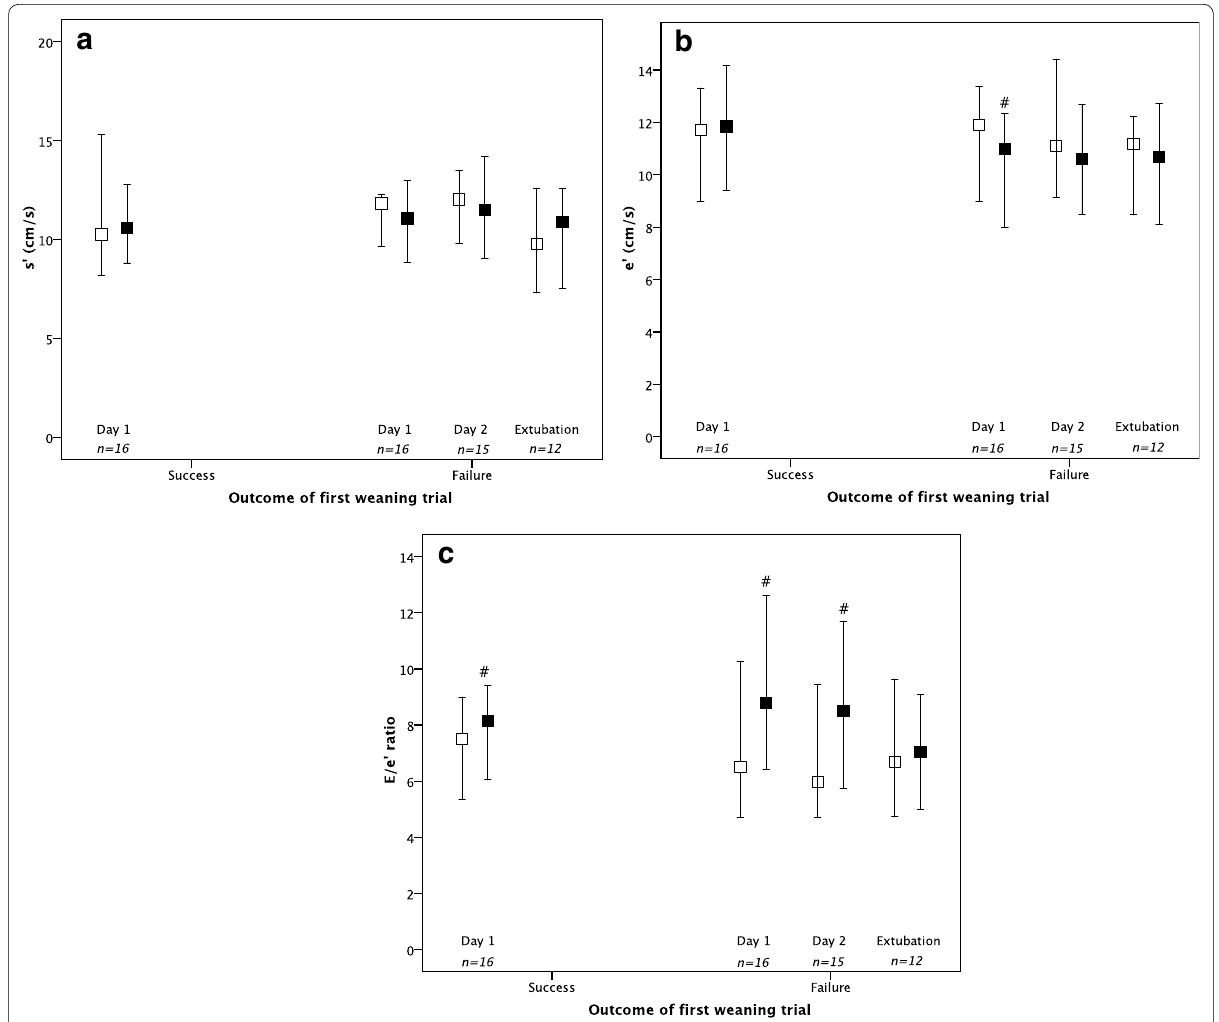
Fig. 3 Tissue Doppler s ′ wave ( a ), e ′ wave ( b ) and E / e ′ ratio ( c ), recorded with echocardiography at the start (white square) and the end (black square) of consecutive weaning trials during the weaning process ( n compared to the start of weaning trial (Wilcoxon